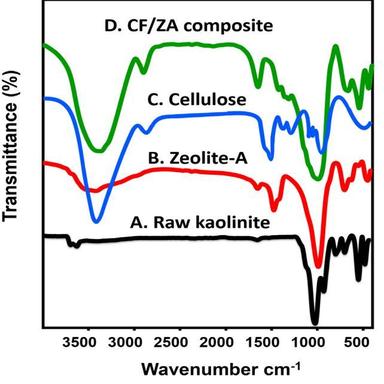
FT-IR spectra of kaolinite (A), synthetic zeolite-A (B), cellulose fibers (C), and synthetic CF/ZA composite (D).